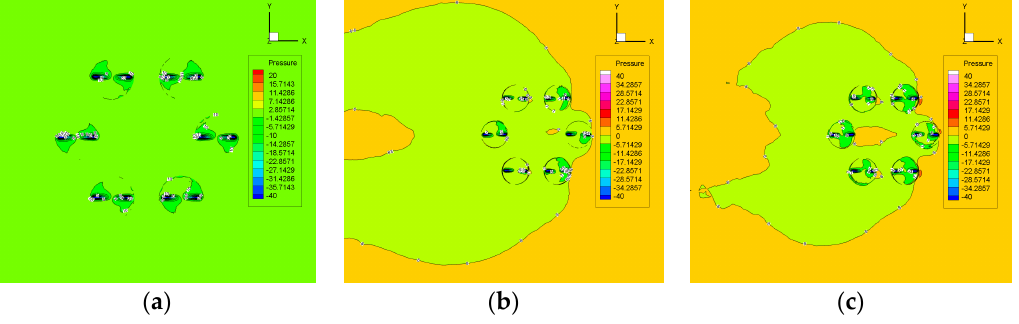
Figure 9. Pressure distribution on the plane upper 10 mm of the center of the Hex-rotor unmanned